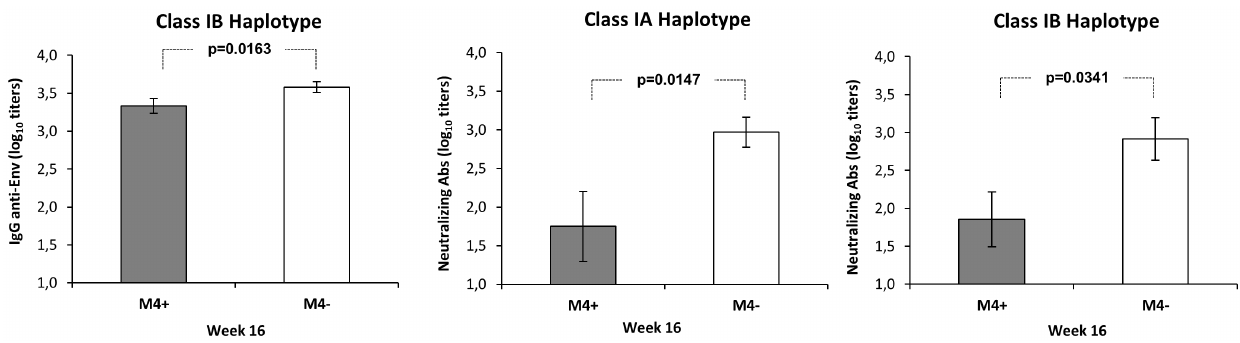
Figure 5. Effects of MHC class I A and I B haplotypes on IgG anti-Env antibodies and neutralizing Ab following infection with SHIV SF162P4cy . Mean values with standard error are depicted for all animals positive or negative for the indicated haplotype: M4 (n=6) non-M4 (n=15) class I A ; M4 (n=7), non-M4 (n=14) class I B .